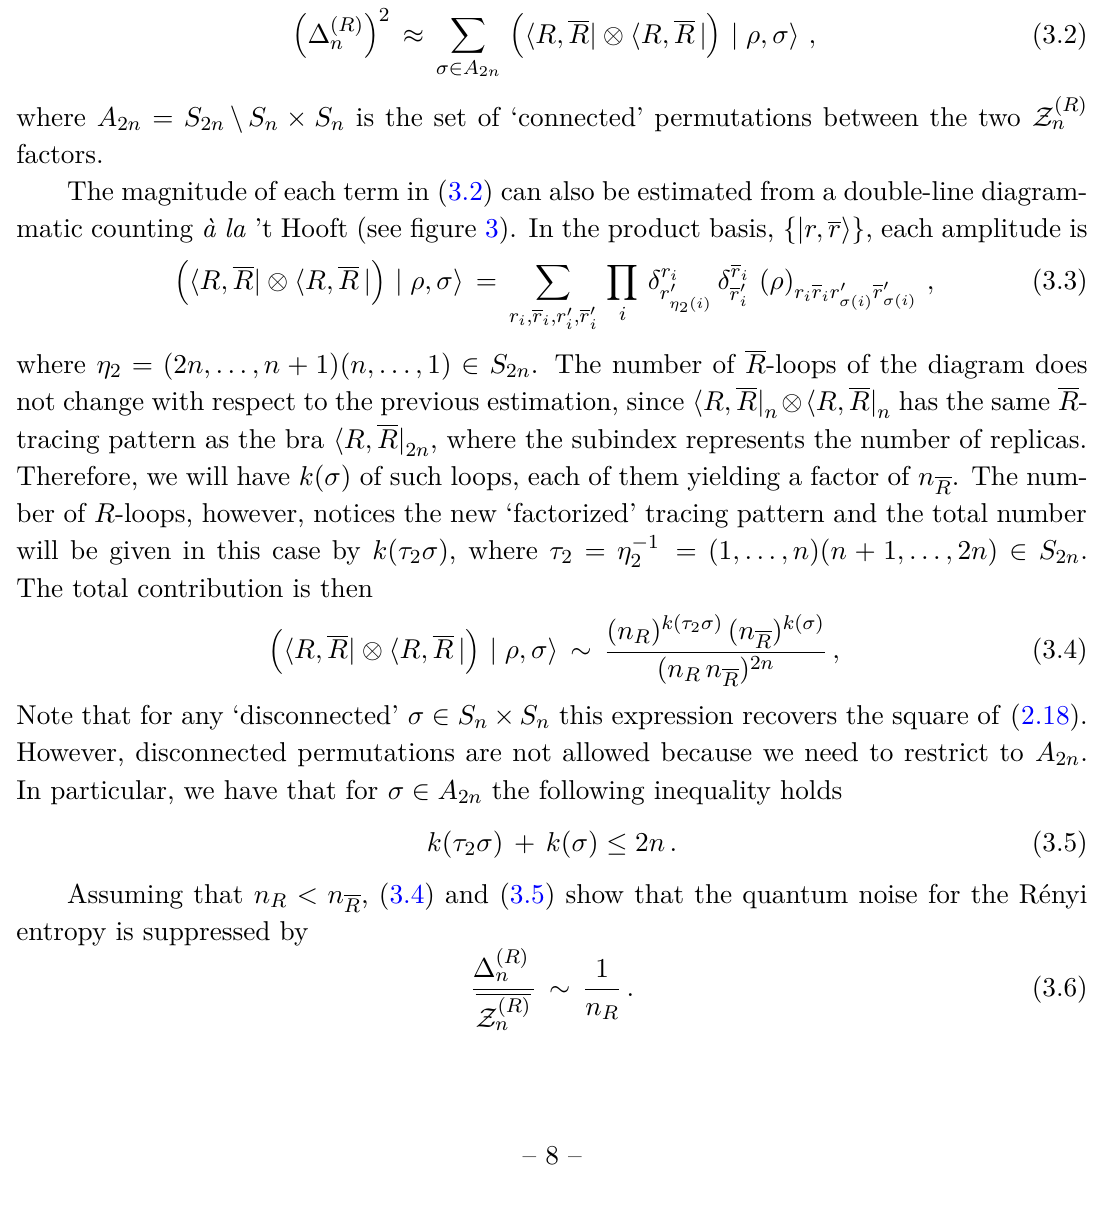
Figure 3 . Double-line diagram corresponding to nected permutation σ = (13)(24) ∈ A 4 . For connected diagrams, the total number of loops is k ( τ 2 σ ) + k ( σ ) = F − 2 = E − V − 2 g , with E = 6 n and V = 4 n . Therefore, only planar permuta- tions σ ∈ A n saturate